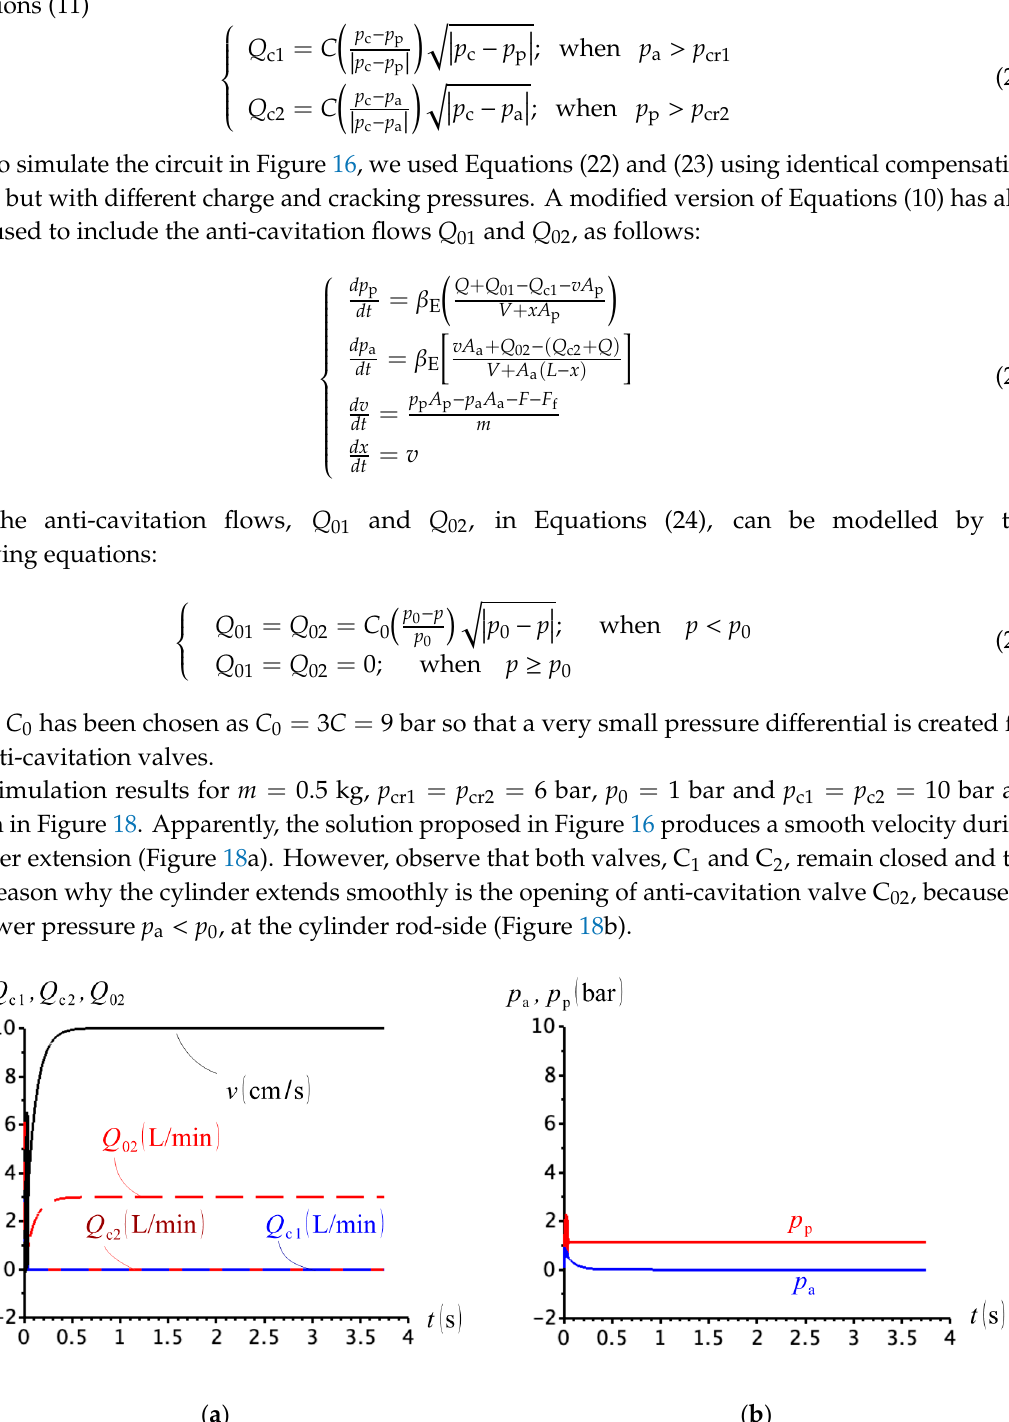
( b ) Figure 19. ( a ) External force, cylinder velocity and compensation flows; ( b ) cap- and rod-side pressures ( (cid:1865) = 250 kg) . The previous results indicate that simultaneous control of two independent valves is not a good solution for asymmetric flow problems. Thus, one can think of replacing the two valves, C 1 and C 2 , with one single valve, so that when one side of the cylinder is connected to the compensation circuit, the other side is hydraulically disconnected. This is the idea behind the circuit in Figure 1d and will be analysed next.